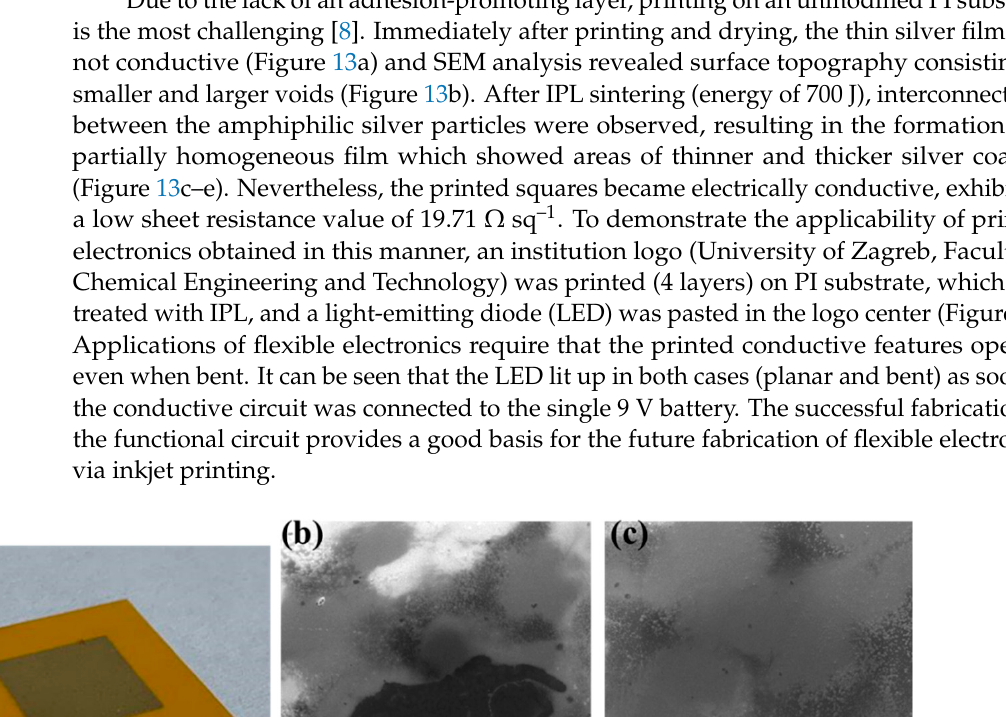
Figure 12. ( a ) Image of the printed silver square on a coated PET substrate before annealing, and SEM micrographs of the thin-film surface ( b ) before and ( c ) after IPL annealing; ( d ) EDX spectra and ( e ) elemental mapping of the prepared conductive features. Shown at 1000× magnification; scale bar 50 μ m.